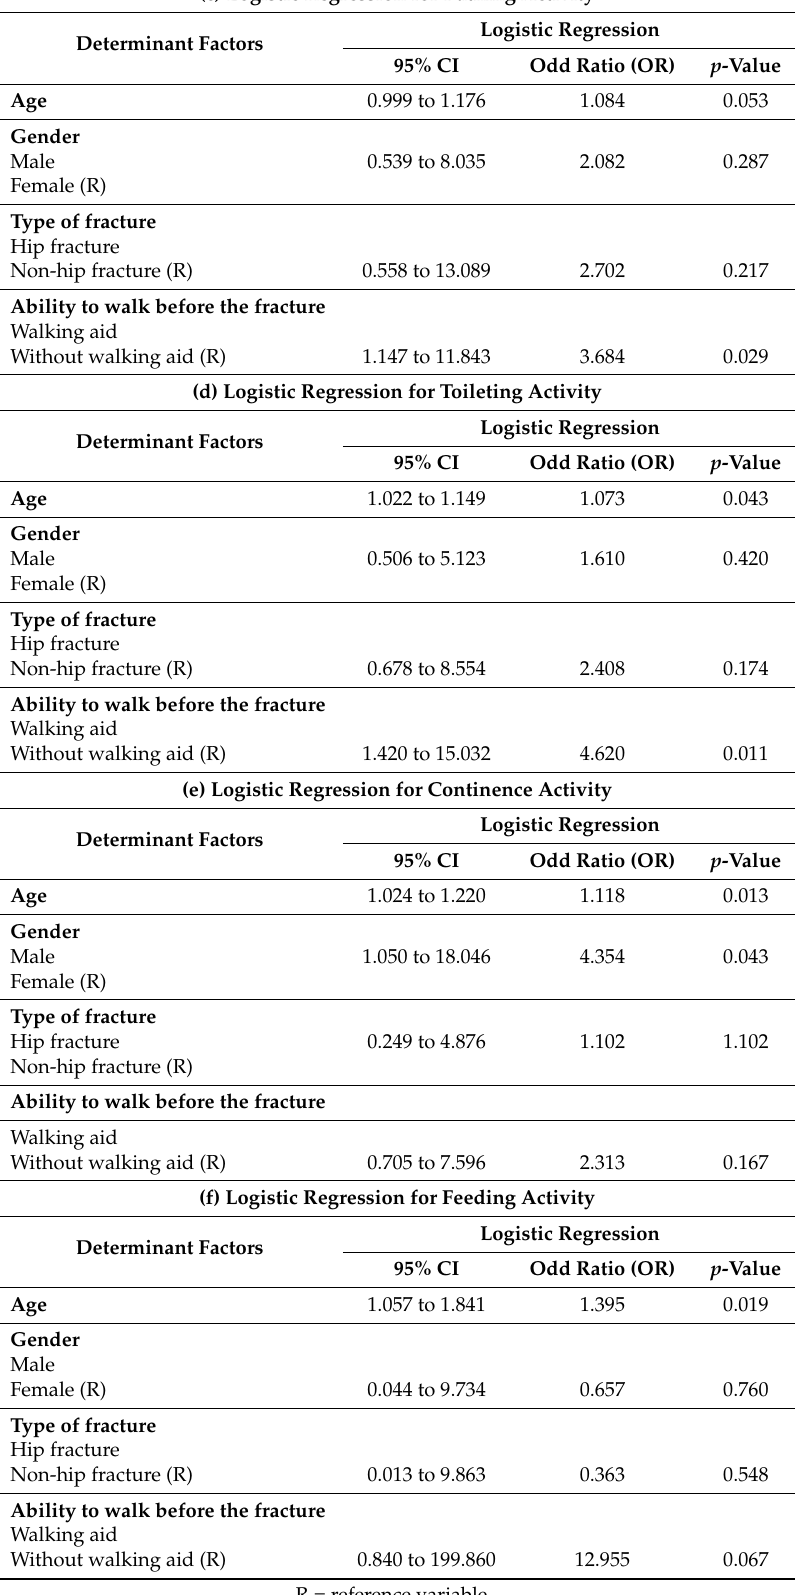
(c) Logistic Regression for Bathing